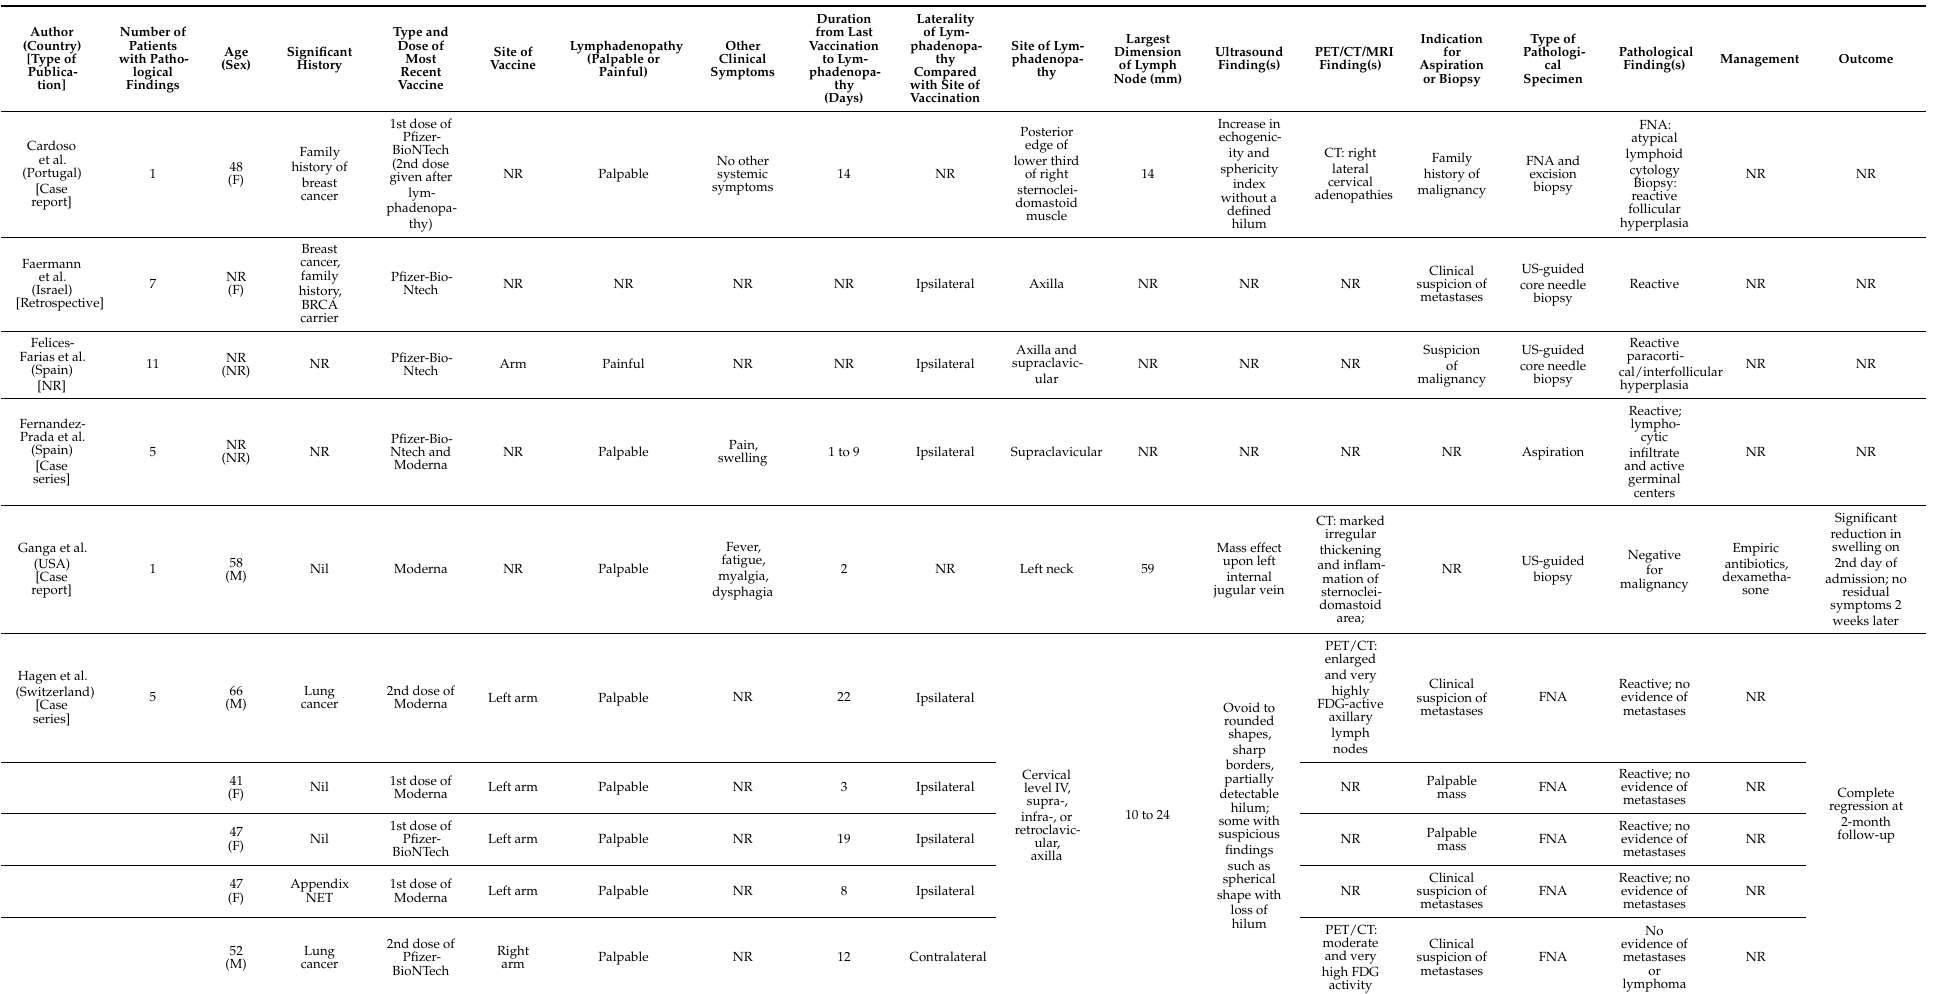
Table 2. Findings of clinical lymphadenopathy (CL) studies. NR, not reported; F, female; M, male; US, ultrasound; PET/CT, positron emission tomography/computed tomography; MRI, magnetic resonance imaging; FNA, fine-needle